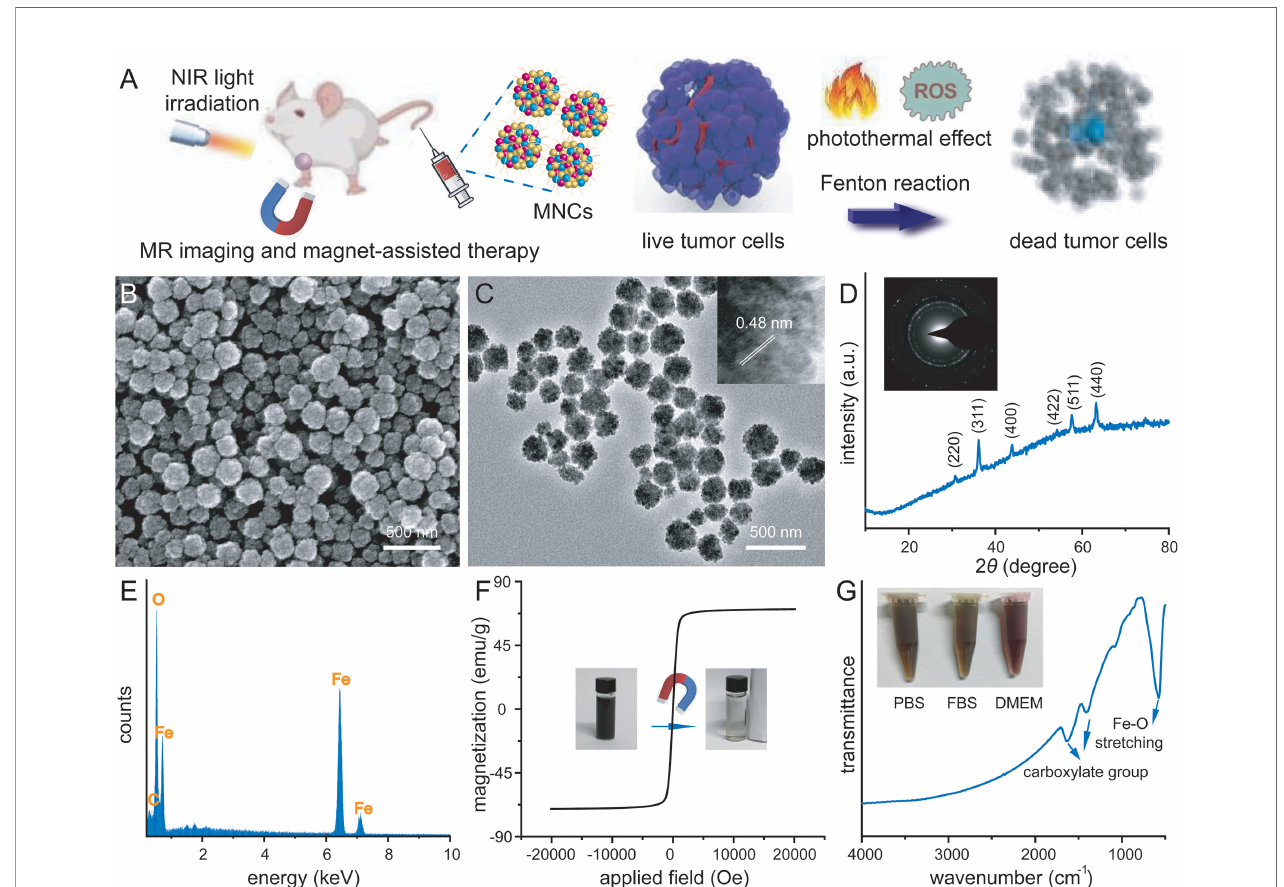
FIGURE 1 | Schematic illustration of tumor-targeting therapy via a PTT-enhanced Fenton reaction and relative antitumor mechanism (A) . SEM image (B) , TEM image (C) , wide-angle XRD pattern (D) , EDS analysis (E) , room temperature magnetic hysteresis loop (F) , and FT-IR spectrum (G) of well-prepared magnetic nanoclusters (MNCs). Inset of (C) : HR-TEM image of MNCs. Inset of D: SEAD image of MNCs. Inset of (F) : photo of magnetic separation process. Inset of (G) : photos of MNCs dispersed in different physiological